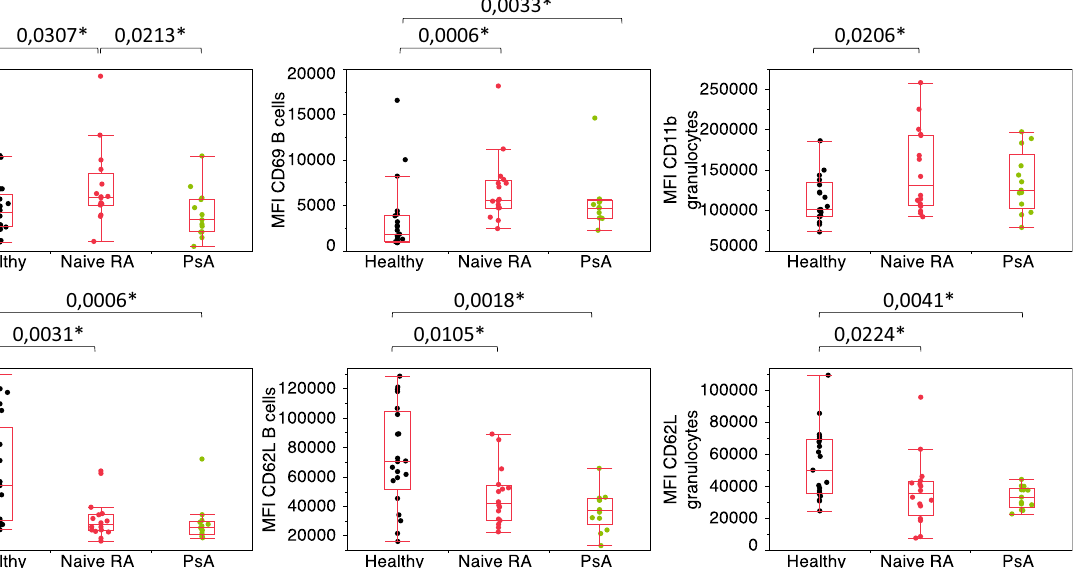
Figure 2. Most discriminative immune marker basal expression in healthy, naïve RA and PsA patients. CD69 Mean Fluorescent Intensity (MFI) expression in NK and B cells, CD11b MFIs in granulocytes, CD62L MFI in monocytes, B cells and granulocytes. Statistical significance was determined by a nonparametric Wilcoxon test, with *p < 0.05. B